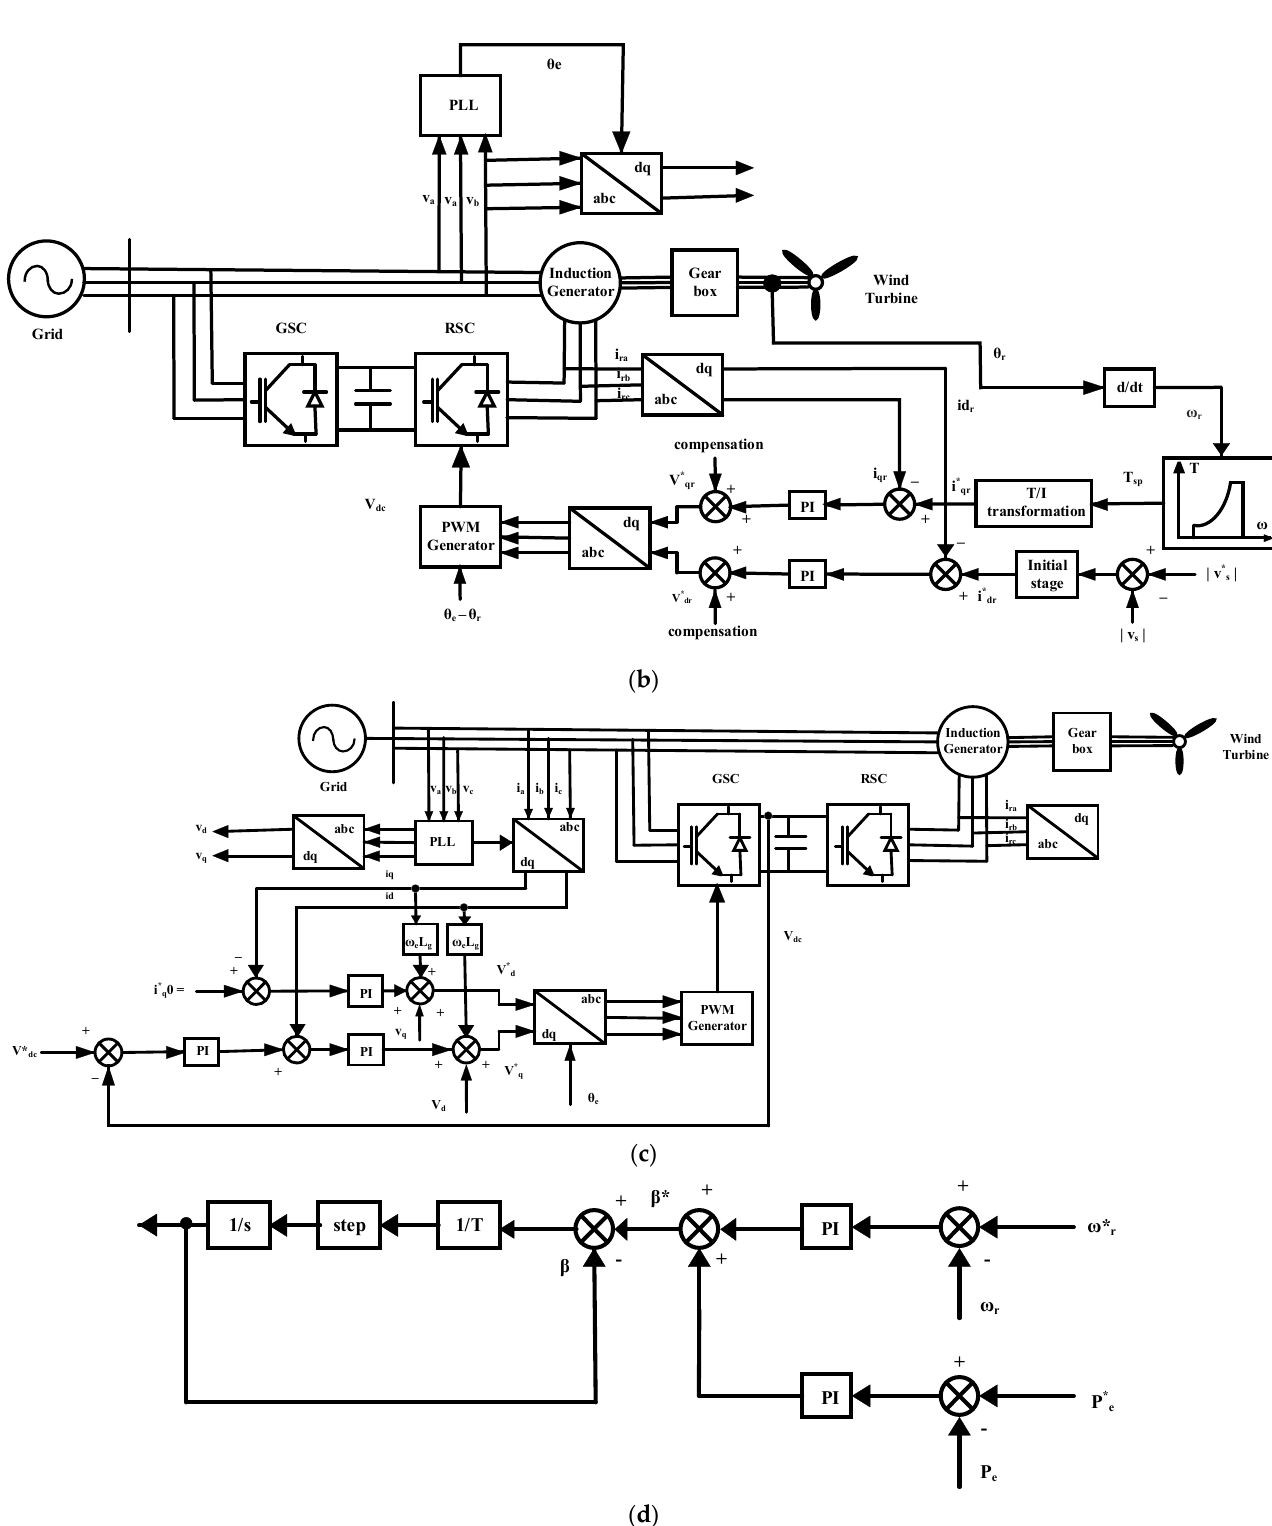
Figure 2. Control scheme of DFIG ( a ) A basic configuration of a DFIG wind turbine ( b ) Overall vector control scheme of the RSC ( c ) Overall vector control scheme of the GSC ( d ) Wind turbine pitch angle controller.